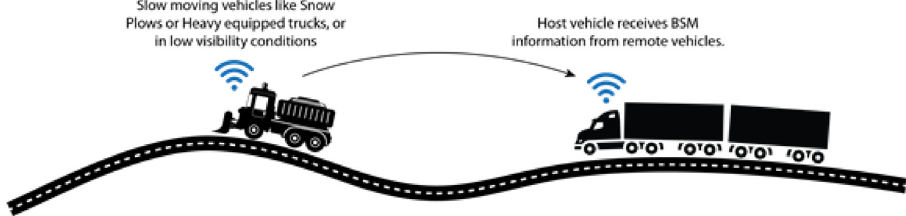
Figure 3 FCW concept diagram (Gopalakrishna et al. , 2016a)